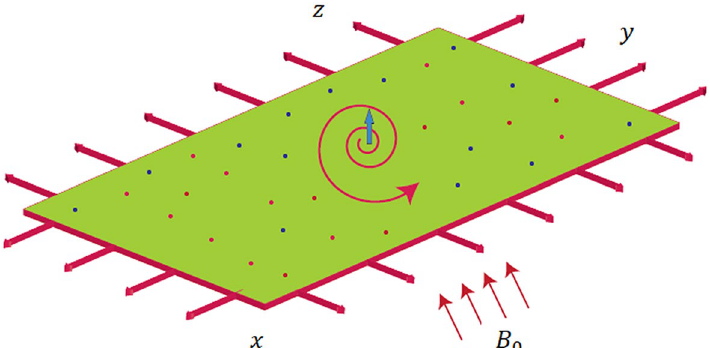
Figure 1. The flow behavior of